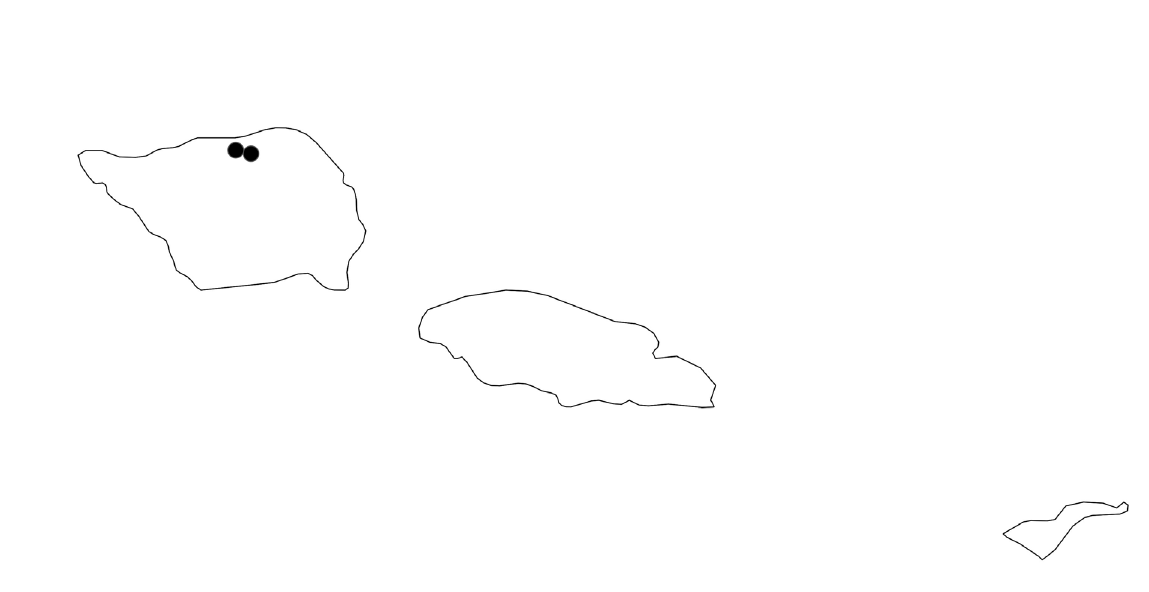
Fig. 8. Map of Samoa showing the collecting localities of Huberantha whistleri I.M.Turner & Utteridge sp.